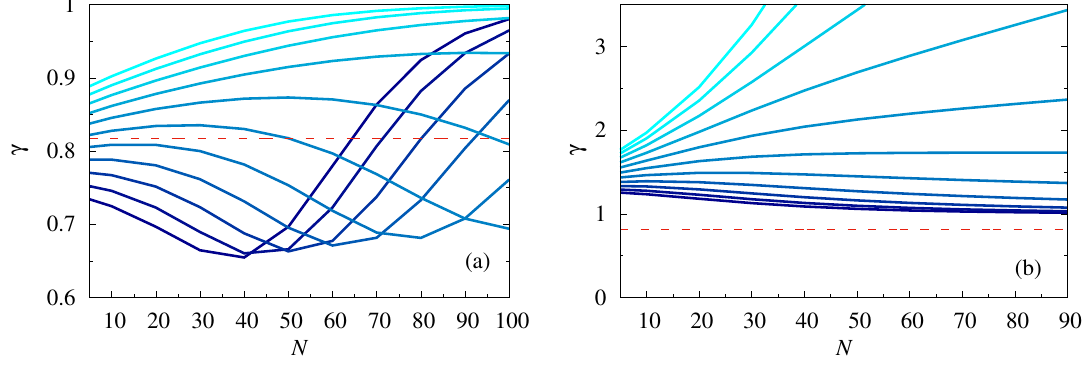
Figure 4. Coefficient of variation γ of the FPTD as a function of N for x = x 0 (panel a ) for x 0 / L ranging from 0.85 to 0.95 with steps of 0.01, and x = x 0 + L /2 (panel b ) for x 0 / L ranging from 0.45 to 0.55 with steps of 0.01 (lighter colors stand for larger values of x 0 / L ) with L 1 = L /2 and h 0 / L = 0.25 and h 1 / h 0 = 0.8. The horizontal dashed line in the panels ( a ) and ( b ) represents the value of γ for x = x 0 for a constant section channel (recall that in this case γ is independent of the polymer length N